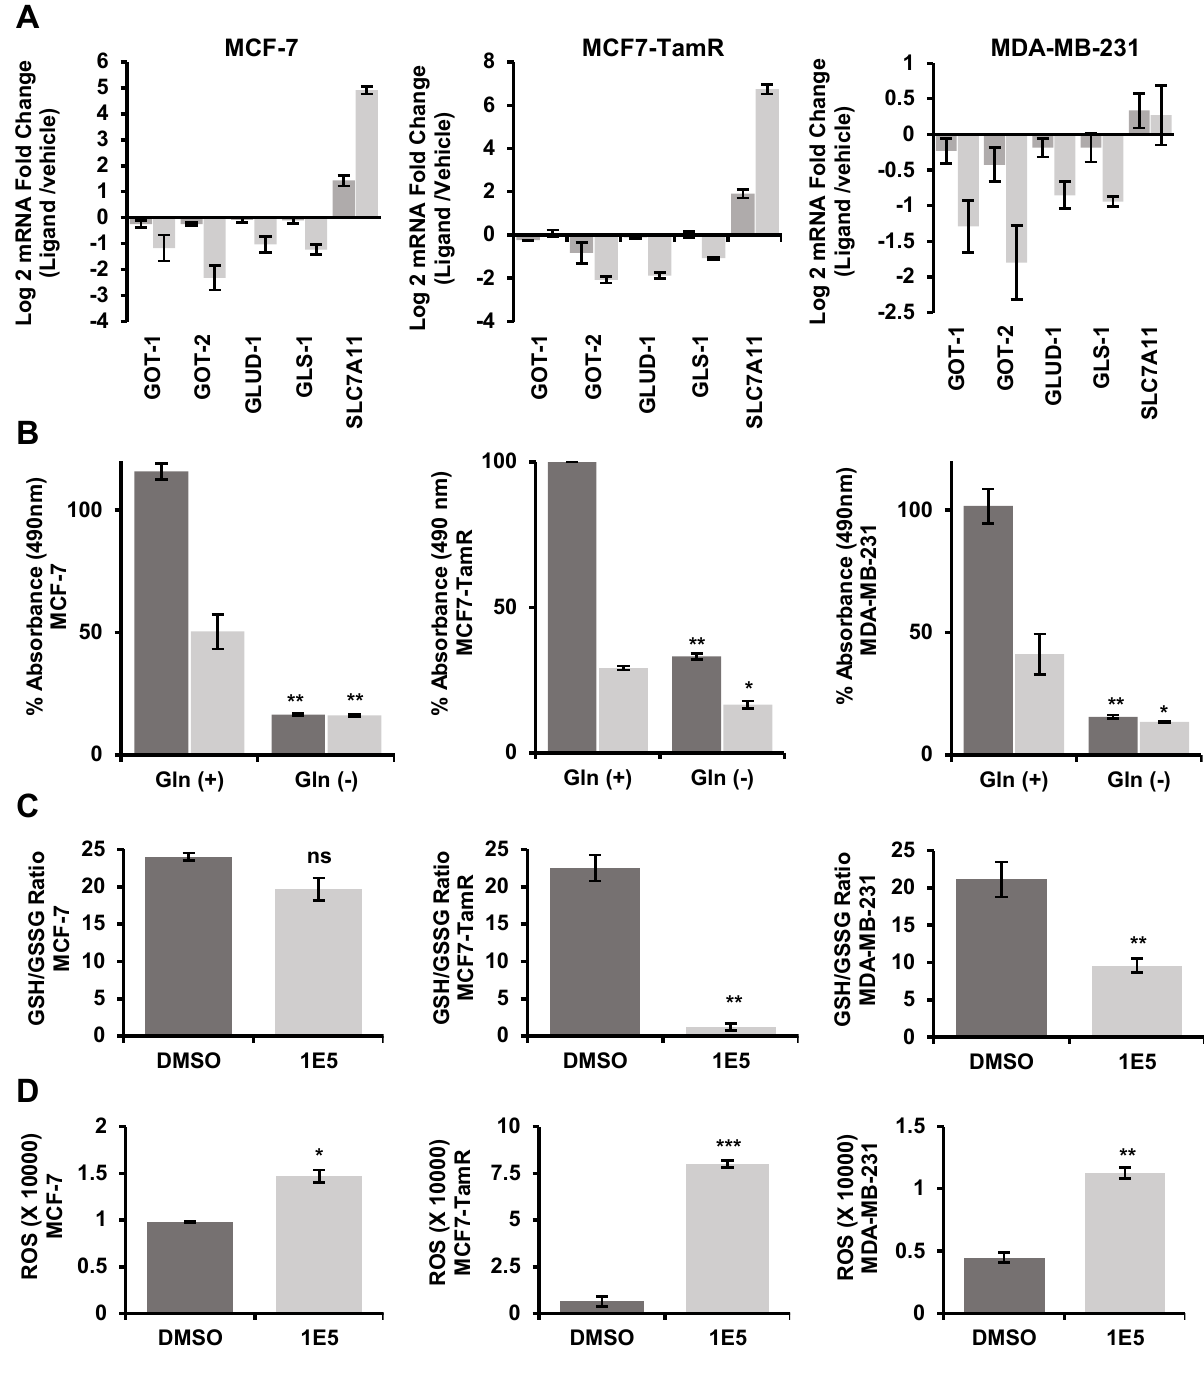
Figure 5. Novel LXR ligand 1E5 induces oxidative stress in breast cancer cells, disrupting glutaminolysis. ( A ) Log2 mRNA expression of known glutaminolysis-related genes GOT1, GOT2, GLUD1, GLS1, and SLC7A11. RNA was extracted after 48 h of ligand treatments. ( B ) MTT analysis of MCF-7, MCF7-TamR, and MDA-MB-231 cells cultured in glutamine-supplemented and stripped media. Cells were treated for 72 h before the MTT assay. ( C ) The ratio of reduced to oxidized (GSH/GSSG) glutathione levels upon 48 h of treatments with DMSO and 1E5. ( D ) Levels of ROS determined as the H 2 O 2 luminescence upon treatments with DMSO and 1E5 in MCF-7, MCF7-TamR, and MDA-MB-231 cell lines for 48 h. The data presented consist of biological triplicates ( n = 3). Standard error has been plotted in necessary sets of data. Statistical significance was determined by Student’s t -test (two-tail, two-sample equal variance), where * p < 0.05, ** p < 0.01, *** p < 0.001, and not significant (ns) p > 0.05.